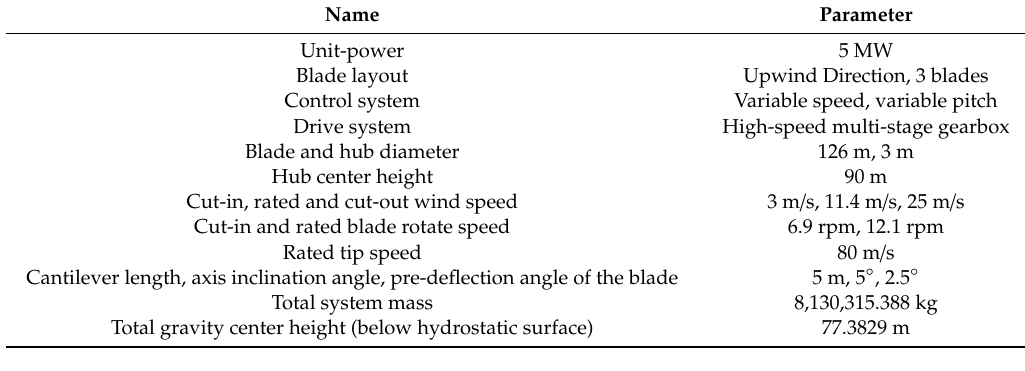
Table 1. Overall parameters of NREL 5 MW wind turbine system.